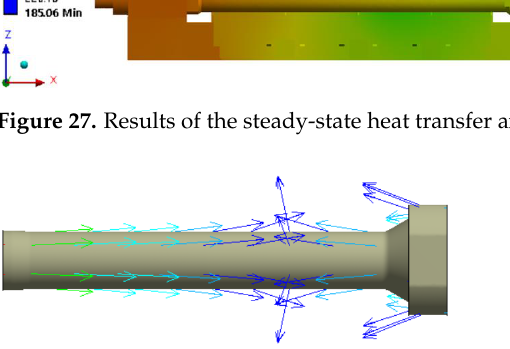
Figure 28. Steady-state heat transfer direction in the stem.